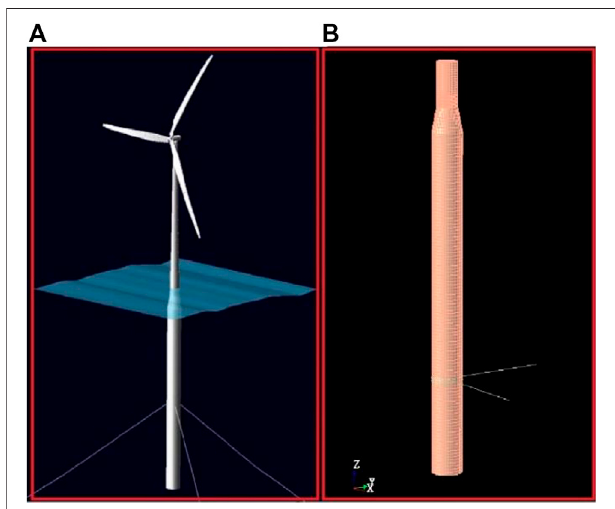
FIGURE 1 | Floating offshore wind turbine: (A) total structure model and (B) mesh